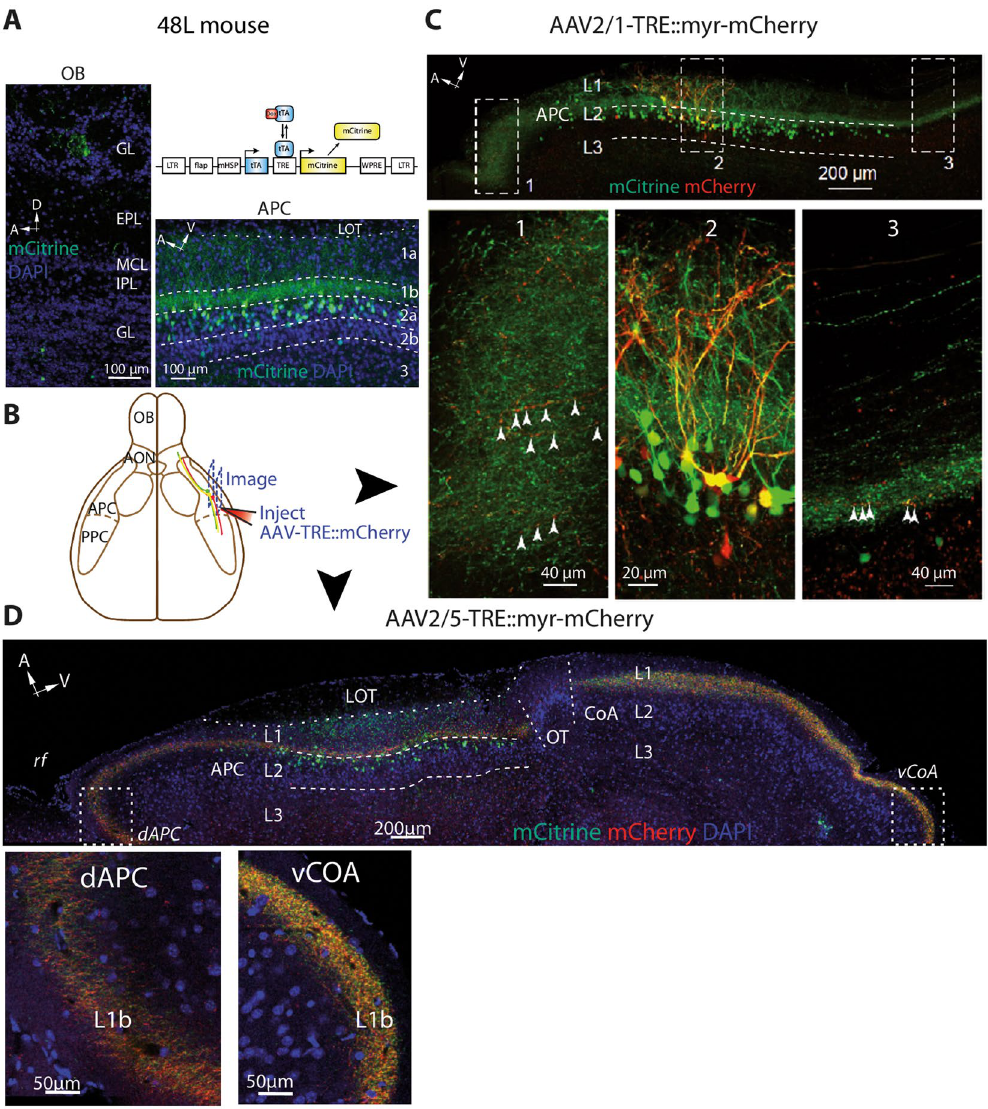
Figure 4. SL cells project widely within the olfactory system as revealed by a transgenic mouse line, 48L. ( A ) tTA constitutionally binds to TRE and drives mCitrine expression in a subset of SL cells (dox off system; up right ). mCitrine + cells were concentrated in layer 2a of the APC ( bottom right ). In the OB ( left ), some cells were observed in the glomerular and granule cell layers and axons were rarely observed. GL: glomerular layer, EPL: external plexiform layer, MCL: mitral cell layer, IPL: internal plexiform layer, GCL: granule cell layer. ( B ) AAVs expressing mCherry under the control of TRE and tTA were injected in the APC to yield sparse dual-labeling and identification of dual-labeled axons away from the injection site. ( C ) AAV2/1-TRE::myr-mCherry injection in the APC led to sparse dual-labeling of mCitrine + cells (box 2). Dual-labeled axons were found several hundred µ m away from the injection site in the same sagittal plane, in the dorsal (box 1) and ventral APC (box 2). n = 2 mice. ( D ) AAV2/5-TRE::myr-mCherry injection in the APC labeled axons several hundred µ m away from the injection site, in a parallel plane. Dual-labeled axons were found in the dorsal APC and in the CoA. OT: Olfactory Tubercle. For B and C, red: mCherry. Green: mCitrine. Blue: DAPI. n = 3